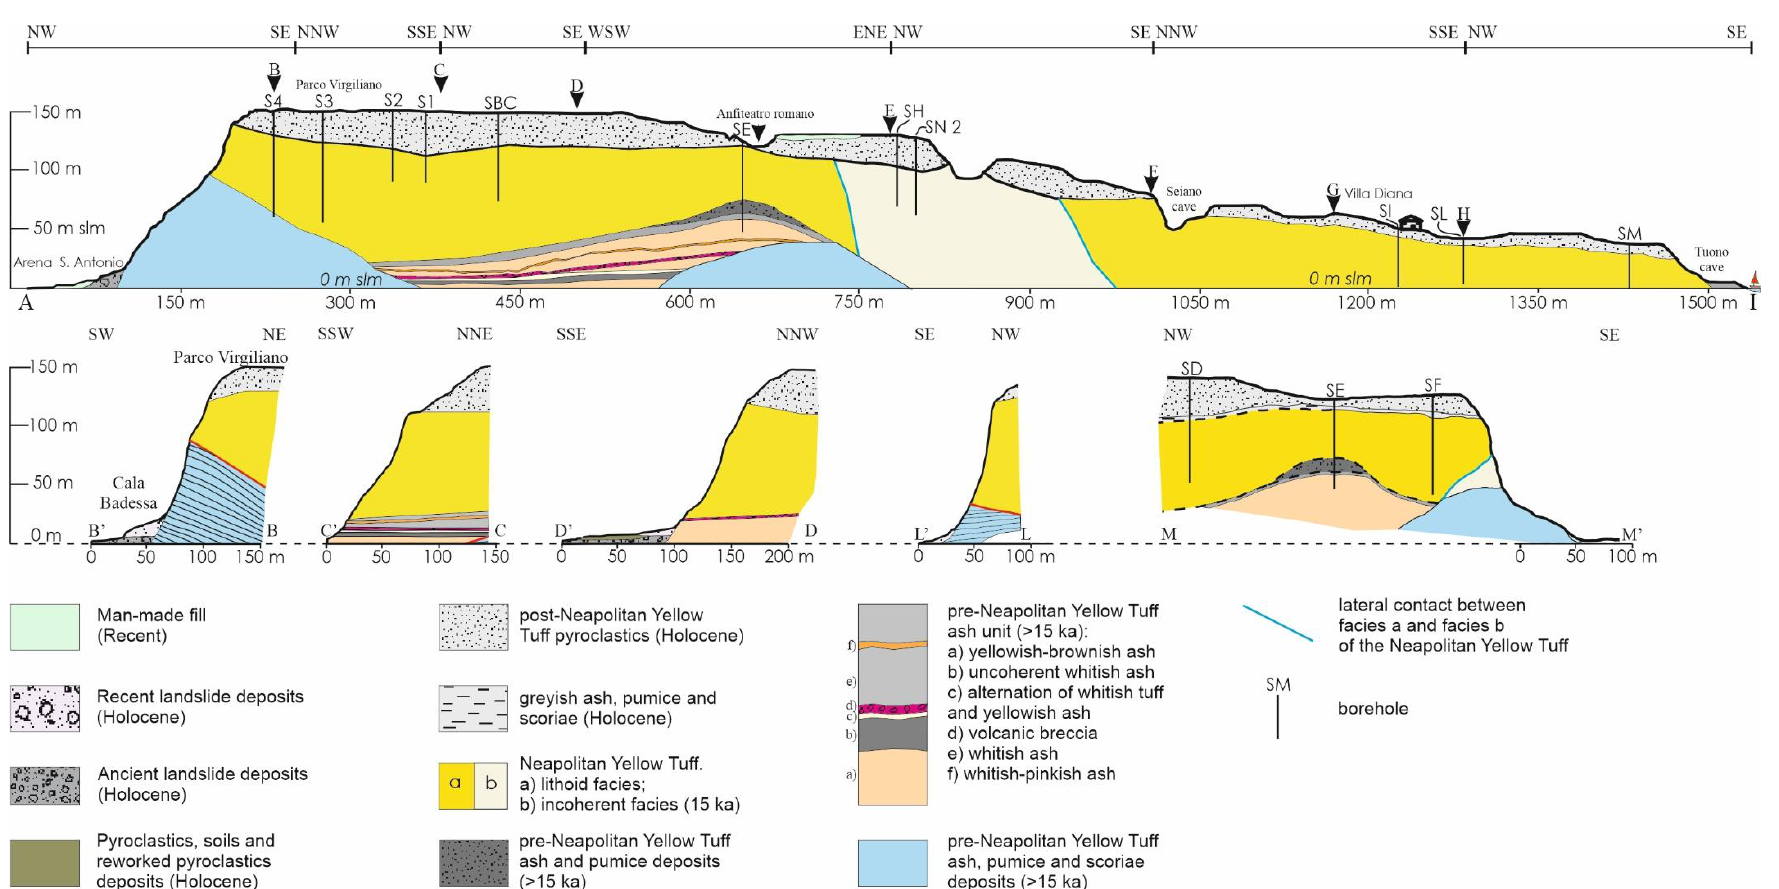
Figure 5. Geological cross-section along the Coroglio-Trentaremi sea-cliff. Cross-section location is reported in Figure 3.